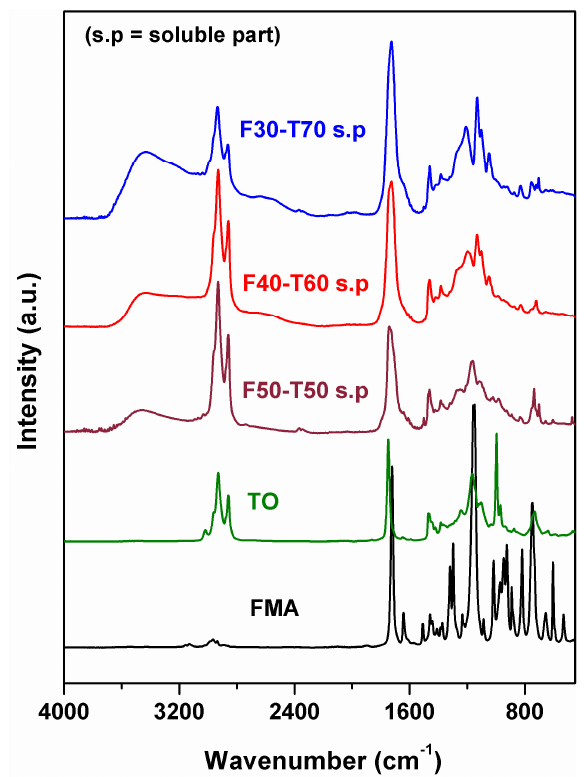
Figure 9. FTIR (Fourier-transform infrared) plots of Soxhlet extracted portions from FMA-TO (furfuryl methacrylate-tung oil) polymers.